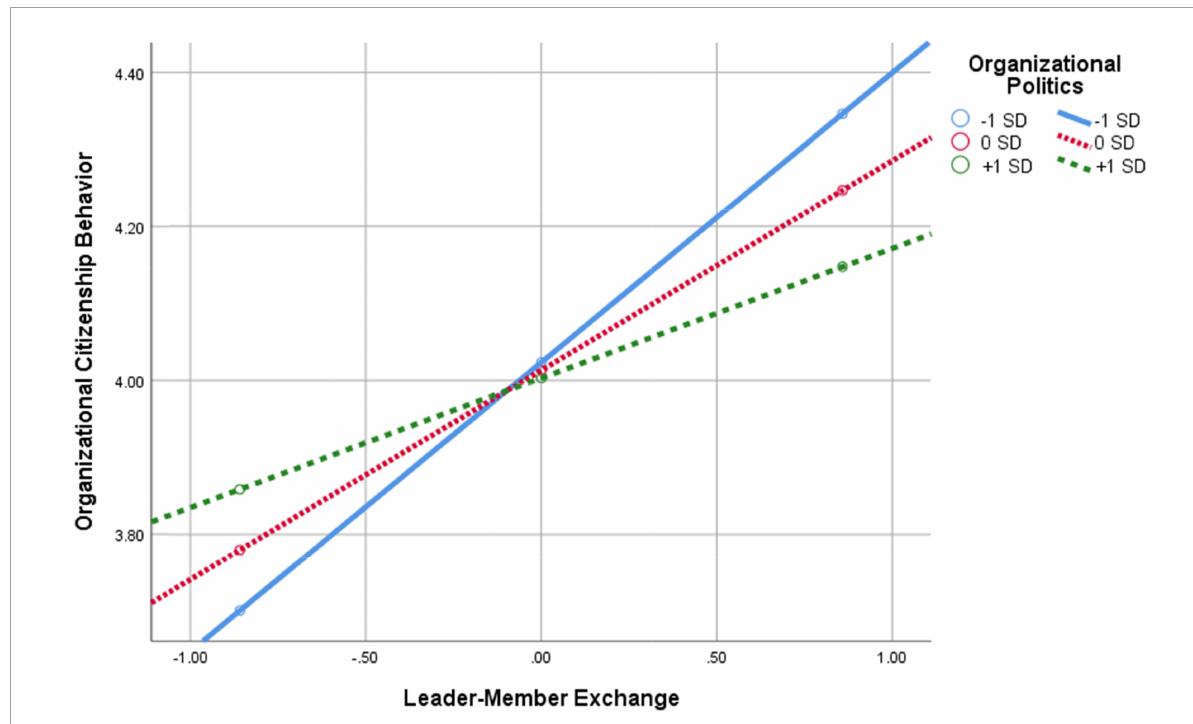
FIGURE5 Interaction of leader–member exchange × perception of organizational politics in predicting OCB.